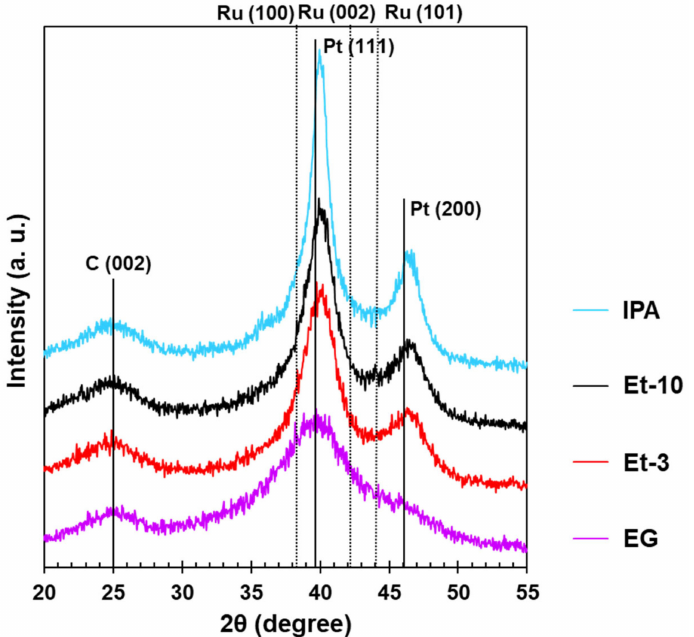
Figure 1. X-ray diffraction patterns of the PtRu/C materials obtained by the ethylene glycol, ethanol, and isopropanol synthesis